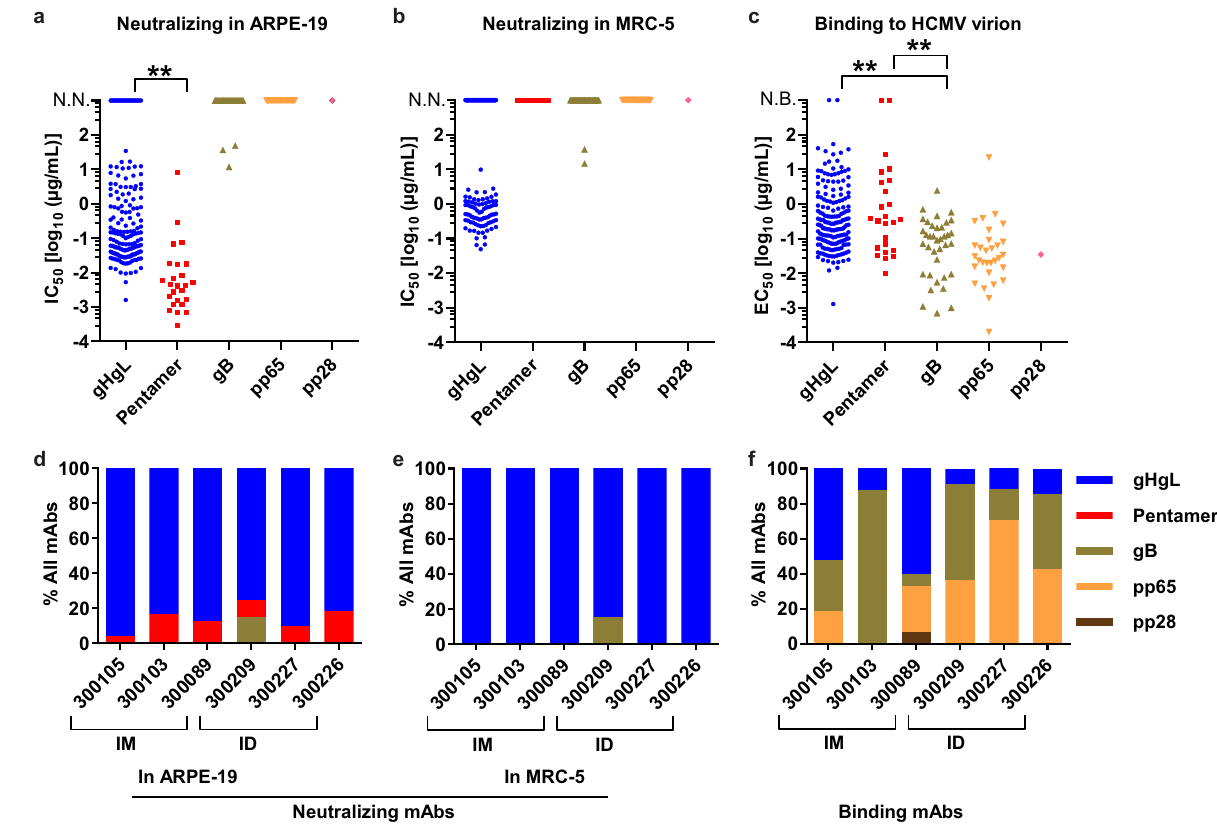
Fig. 2 V160 induces neutralizing and binding antibodies targeting diverse antigens in the HCMV-seronegative subjects. Neutralization potency was quanti fi ed by IC 50 , de fi ned as the concentration of the IgG required to block 50% viral entry into ARPE-19/MRC-5 cells. The binding af fi nity of the antibodies to HCMV virion was quanti fi ed by EC 50 , de fi ned as the concentration of the IgG required to achieve 50% of the maximal binding signals in ELISA. a The neutralization potency in ARPE-19 cells of mAbs grouped based on their antigen speci fi city. b The neutralization potency in MRC-5 cells of mAbs grouped based on their antigen speci fi city. c The relative binding af fi nity of mAbs based on their antigen speci fi city. d Distribution of neutralizing mAbs targeting different antigens in each of the six subjects as assessed in ARPE-19 cells and e MRC-5 cells. f Distribution of binding mAbs targeting different antigens in each of the six subjects. The subjects are indicated with the subject numbers 300105, 300103, 300089 in the intramuscular injection group (IM), and 300209, 300227, 300226 in the intradermal injection group (ID). Unpaired two-tailed t test was performed. Differences with statistical signi fi cance are shown with p values, “ ** ” indicates p < 0.001. The data are representative of two independent experiments. N.N. indicates no neutralizing activity. N.B. indicates no binding to the HCMV